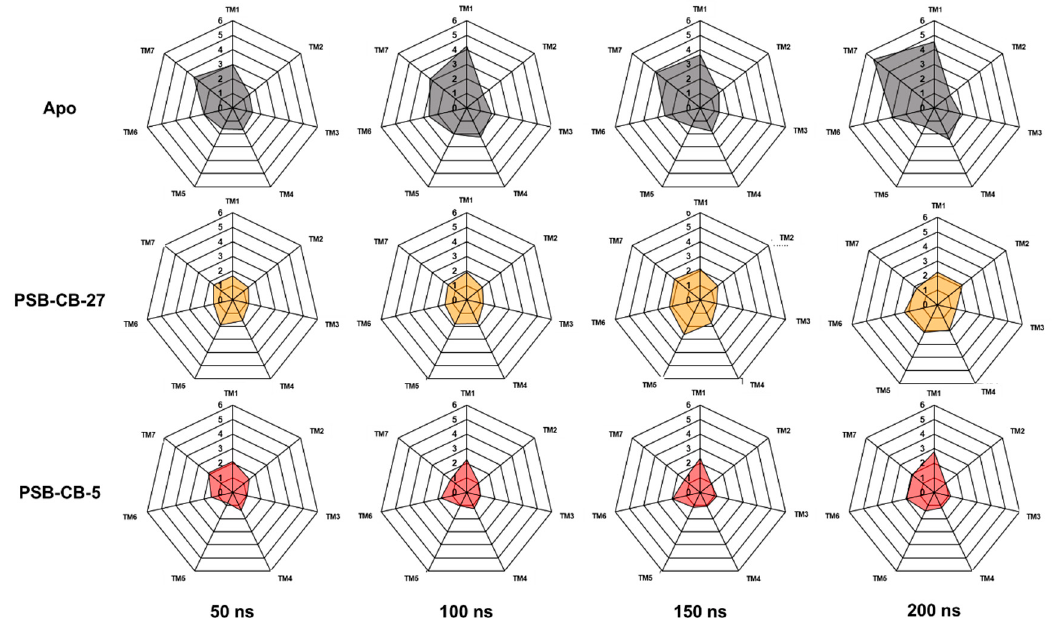
Figure 5. RMSD values for the transmembrane (TM) regions during the 200 ns MD simulation runs. Values were calculated based on the initial complex state after equilibration (0 ns).